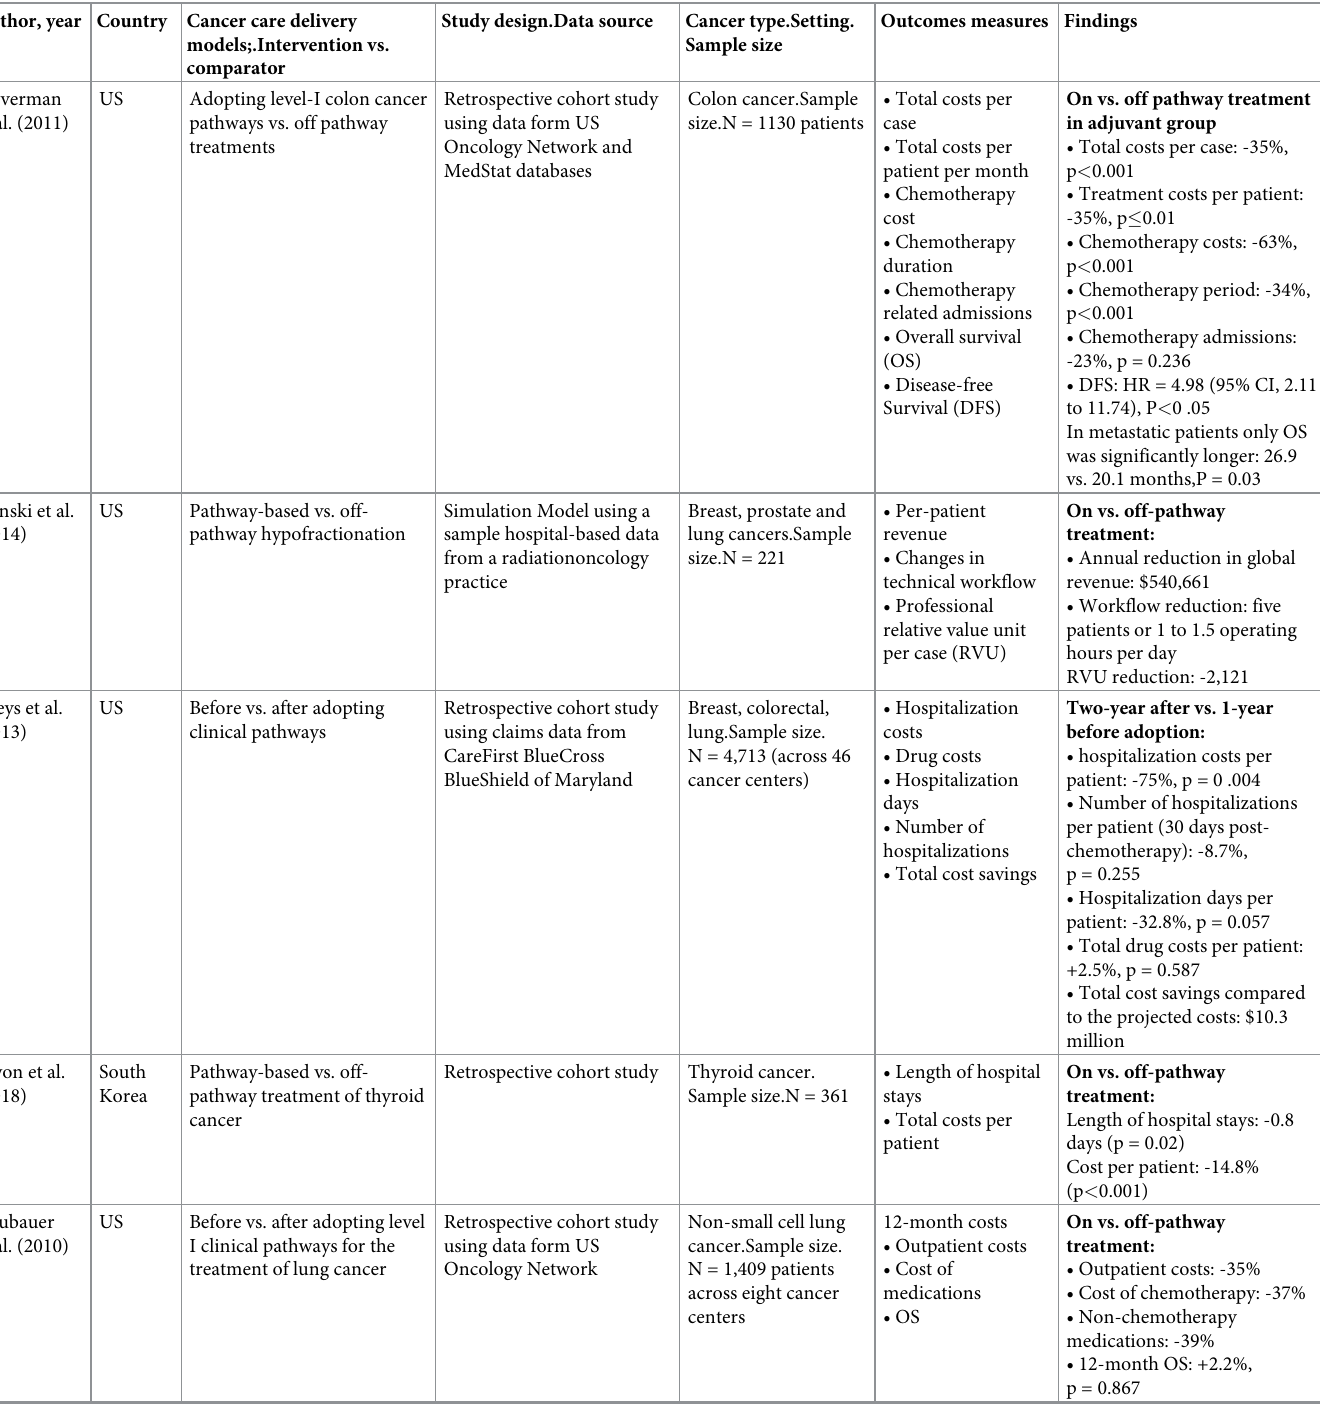
Table 3. Summary of the studies reporting data on implicit payment reforms through care coordination in oncology practice. Author, year Country Cancer care delivery models;.Intervention